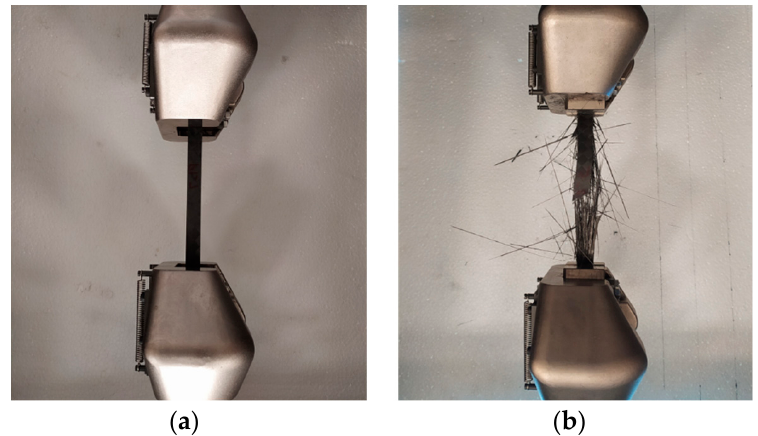
Figure 8. ( a ) Tensile specimen before test ( b ) Tensile specimen after test.